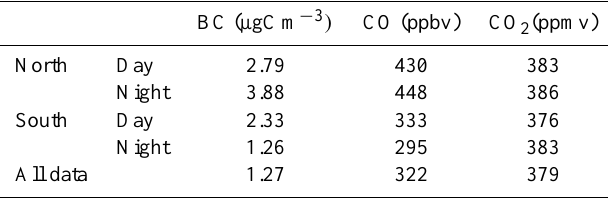
Table 3. Background concentrations (1.25 percentiles) of BC, CO, and CO 2 .